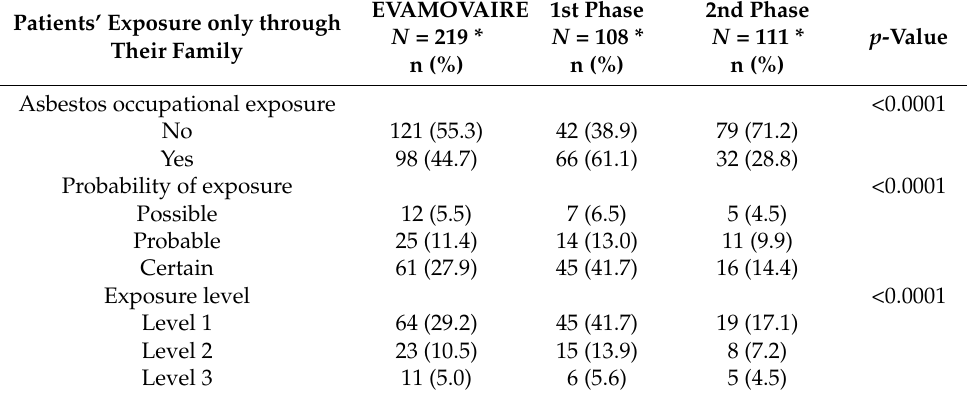
Table 5. Estimation of patient exposure only through their family ( N = 219).